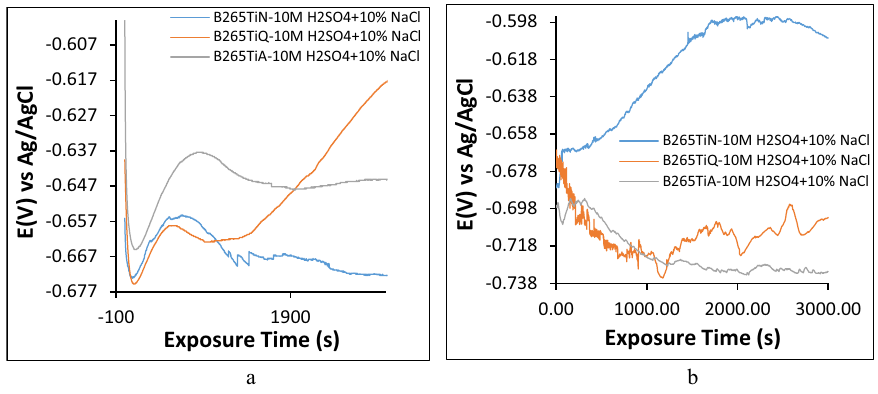
Figure 14: OCP plots of B265TiN, B265TiQ, and B265TiA alloy corrosion in 10 M H 2 SO 4 + 10% NaCl solution at ( a ) 30°C and ( b )